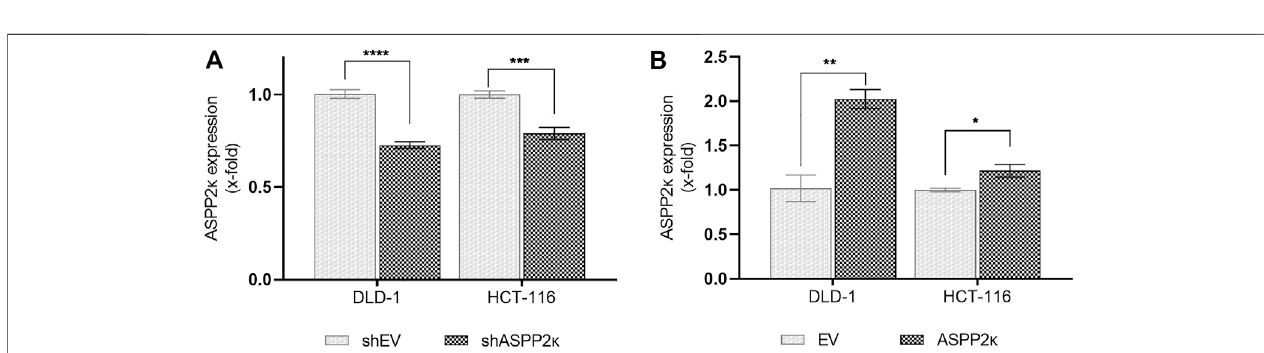
FIGURE 2 | (A) Hairpin mediated ASPP2 κ -interference or (B) forced overexpression of ASPP2 κ determined by isoform-speci fi c qRT-PCR. EV, empty vector. Statistical test: two-way ANOVA. **** p < 0.0001, *** p < 0.001, ** p < 0.01, * p < 0.05.